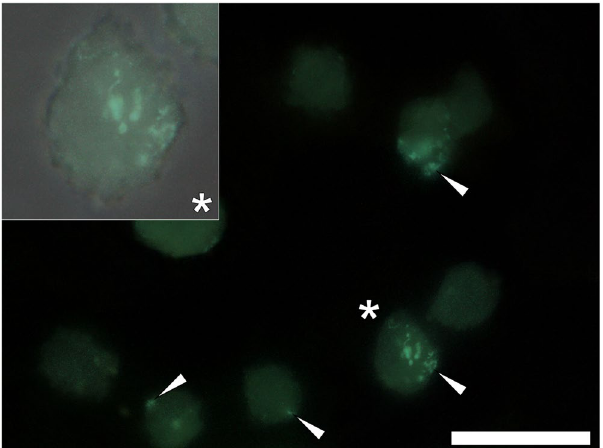
Figure 1. Representative fluorescence microscopy of whole THP-1 cells cultured for 1 h in R10 medium containing 10 μ M thioflavin T (ThT) in the presence of 4 μ M A β 42 . Cells were fixed in 4% w/v PFA, washed in 50 mM PIPES buffer, pH 7.4 before mounting with Fluoromount ™ (Sigma Aldrich) on poly-lysine coated slides. ThT fluorescence (green) is depicted (Olympus long bandpass U-WMBV2 filter cube) with the magnified insert denoted ( * ) of which the bright-field image has been overlaid. White arrows highlight the presence of ThT- reactive deposits within THP-1 cells. Magnification X 1000, scale bar: 20 μ